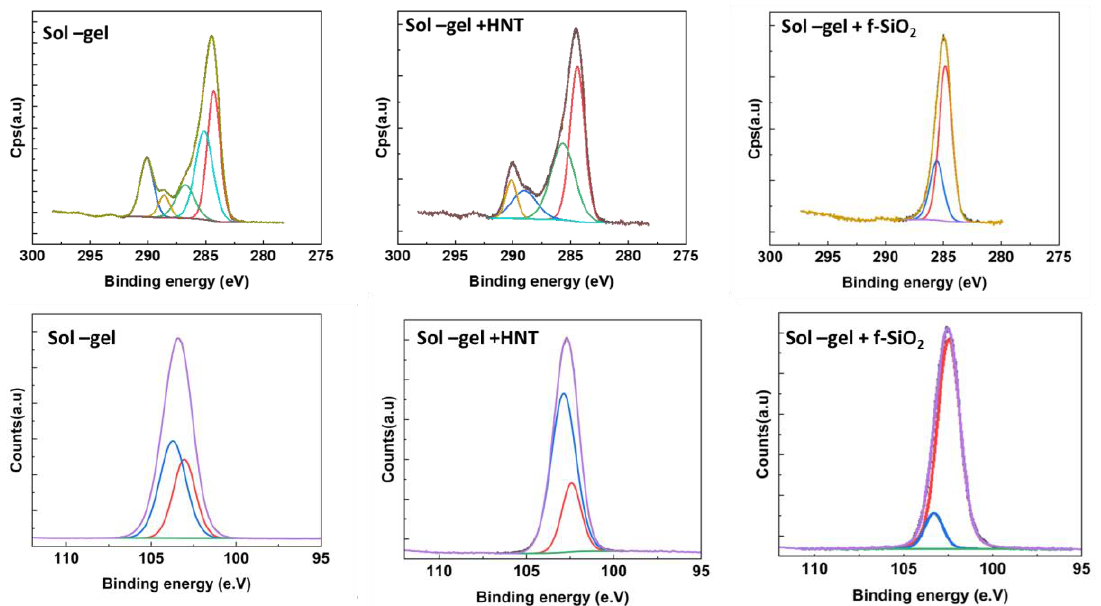
Figure 5. High-resolution XPS spectra of the C1s and Si 2p core level for sol – gel, sol – gel + HNT, and sol – gel + f-SiO 2.